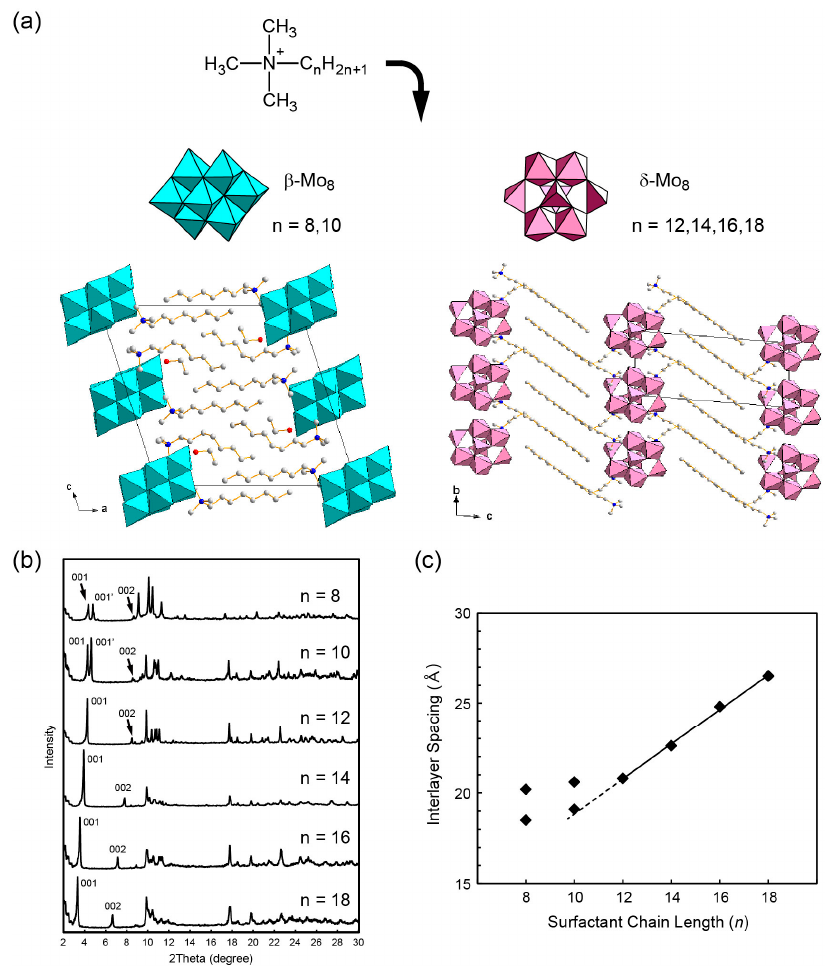
Figure 9. ( a ) Crystal structures of C n NC 3 –Mo 8 hybrid crystals; ( b ) powder X-ray diffraction patterns of